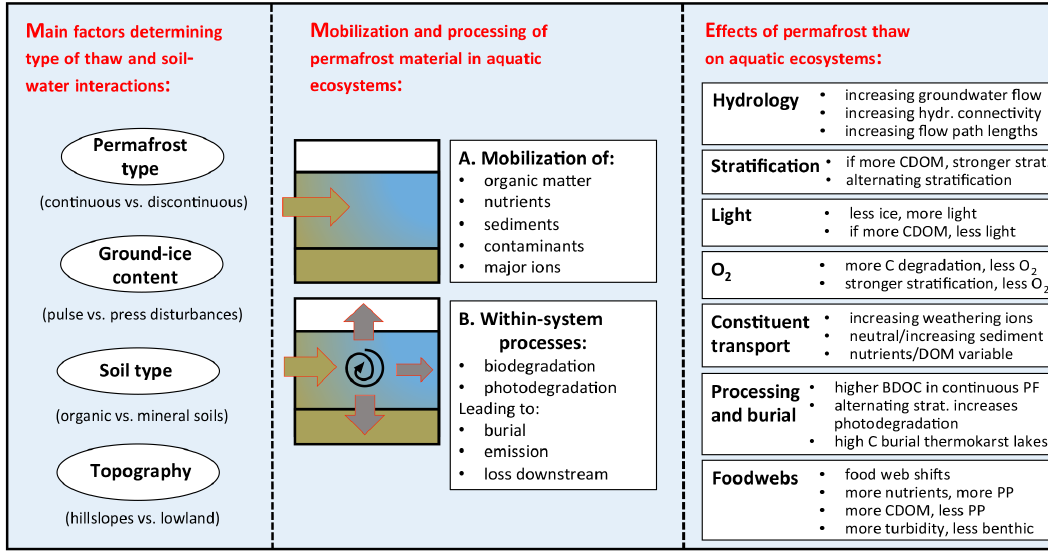
Figure 3. Conceptual diagram of (left) factors determining thaw type and soil-water interactions, (middle) mobilization and processing of permafrost material into aquatic ecosystems, and (right) effects of permafrost thaw on aquatic